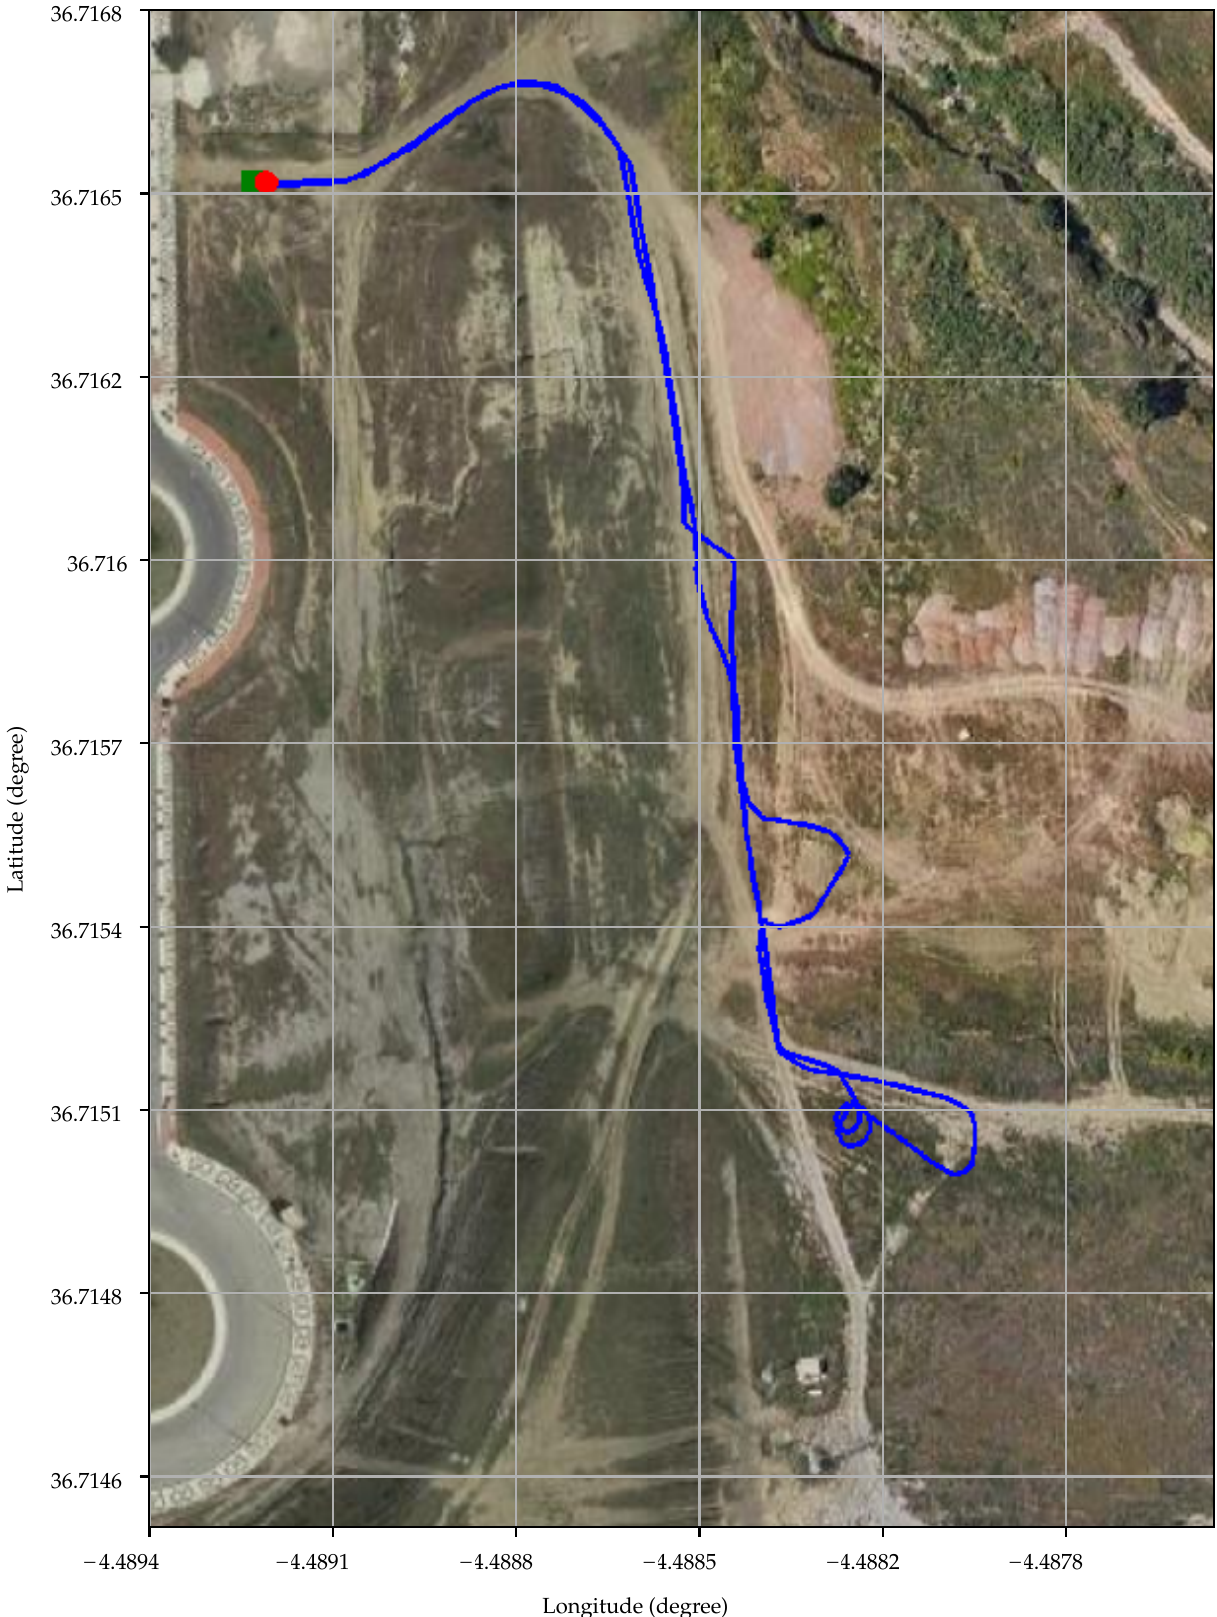
Figure 11. Aerial view of the path followed by the rover on the